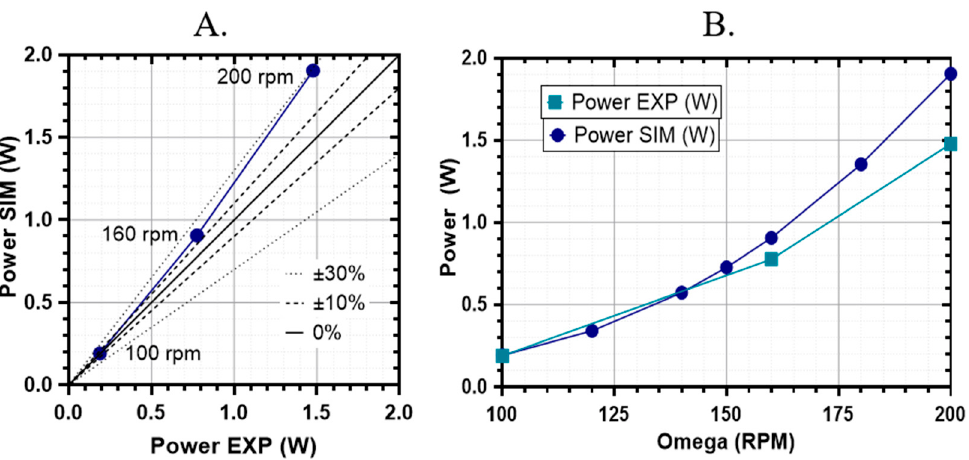
Figure 4 . ( A) The first experimental process approximation for the calculation of power on Brunswick Bioflo / CelliGen 115 bioreactor using the impellers with inclined paddles. The curves for simulated power ( ● ) and experimental data ( ■ ). ( B) Analysis between the experimental and simulated data for the power of Brunswick Bioflo / CelliGen 115 bioreactor using impellers with inclined paddles.